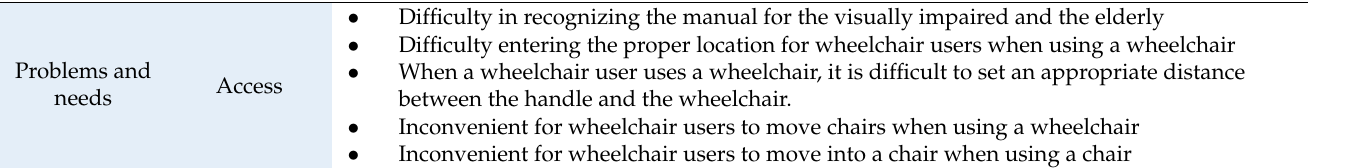
Table 8. Problems of existing arm ergometer and concept ideas applying universal